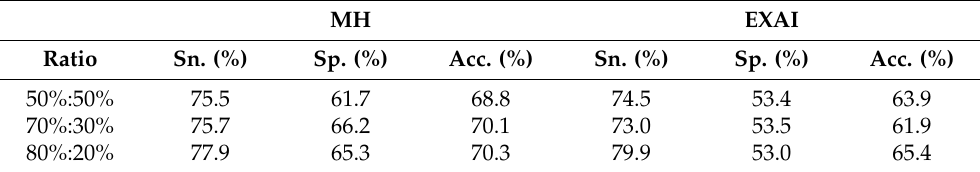
Table 6. Results for the examined ratios of the number of examples for training and testing.